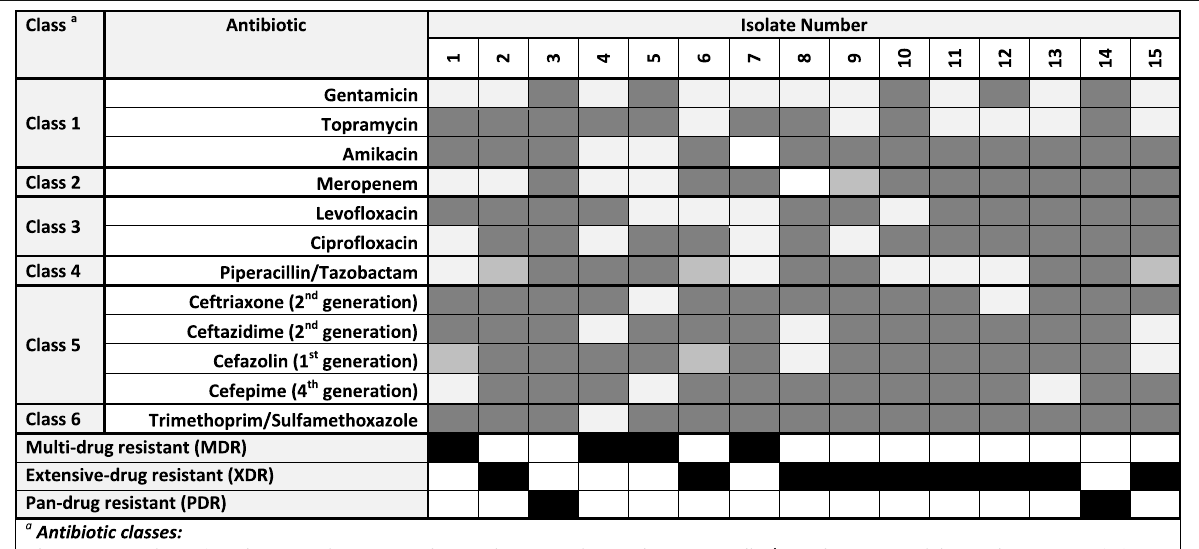
Table 5 Antibiotic resistance pattern among the different other different isolates